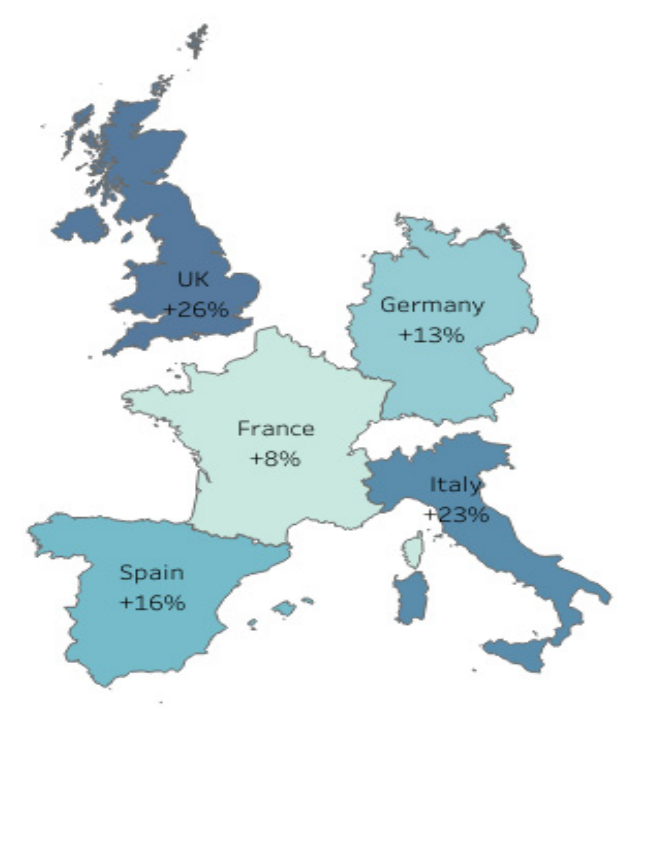
Figure 4. Mean estimates of the increase in IVE in the absence of egg adaptations for A(H3N2) per country (TIV and QIV only). The figure was developed using Tableau (https://www.tableau.com; accessed on 9 August 2021) based on data generated in this study and is a copyright of Medialis Limited.